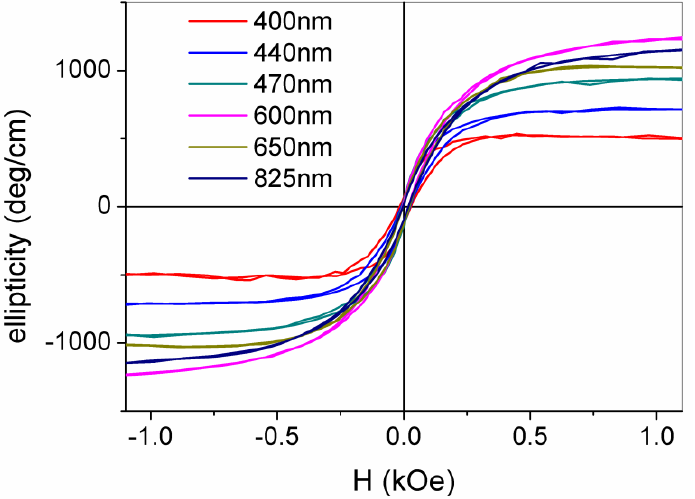
Figure 8. Room temperature magneto-optic hysteresis cycles of the HD2 films at different sub- bandgap wavelengths, starting from λ = 400 nm. Reproduced with permission from [74]. Copyright 2019 Royal Society of Chemistry.